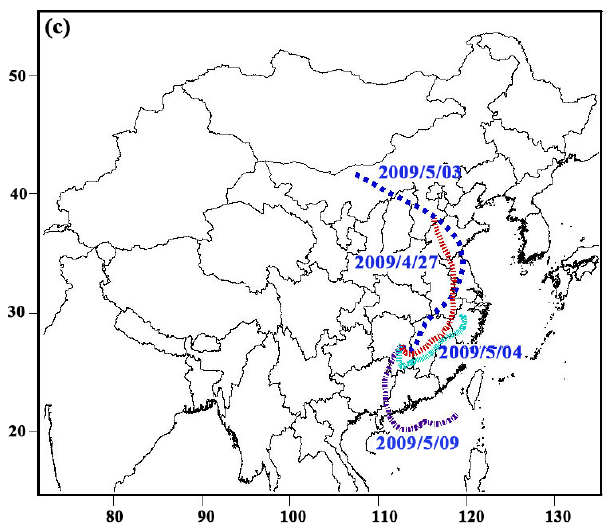
Figure A1. The backward trajectories of the selected air masses based on the LMW and HMW PAH concentrations, ( a ) LMW » HMW, ( b ) LMW ≈ HMW, ( c ) LMW «